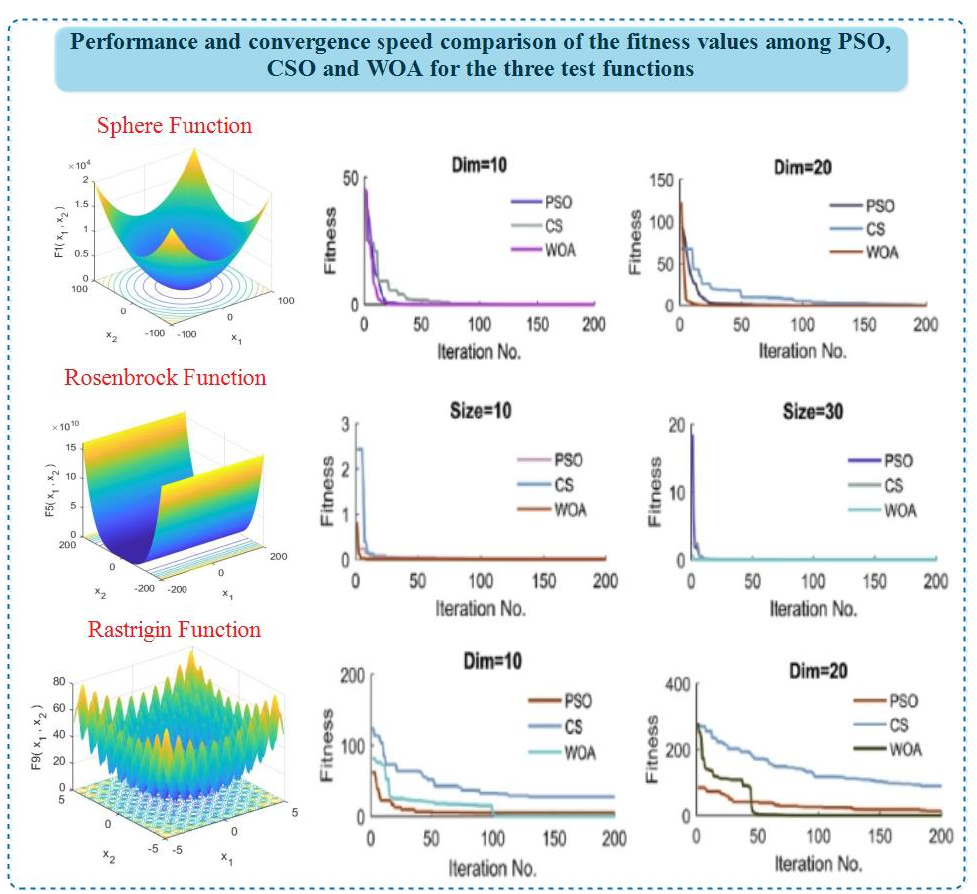
Figure 5. Performance and convergence speed comparison of the fitness values among Particle Swarm Optimization (PSO), Cuckoo Search Algorithm (CSO), and Whale Optimization Algorithm (WOA) for the three test functions.